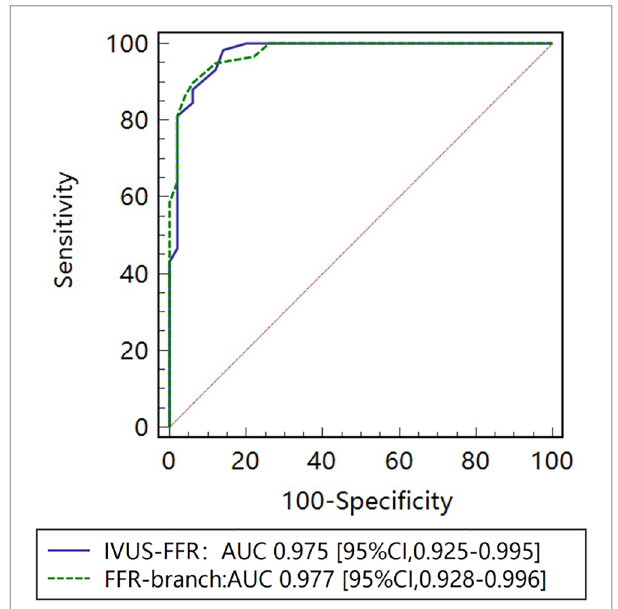
FIGURE 8 Receiver operating characteristic (ROC) curves for diagnosis of physiologically signi fi cant stenosis. The diagnostic performance of IVUS-FFR is very close to that of the FFR-branch. AUC indicates the area under the